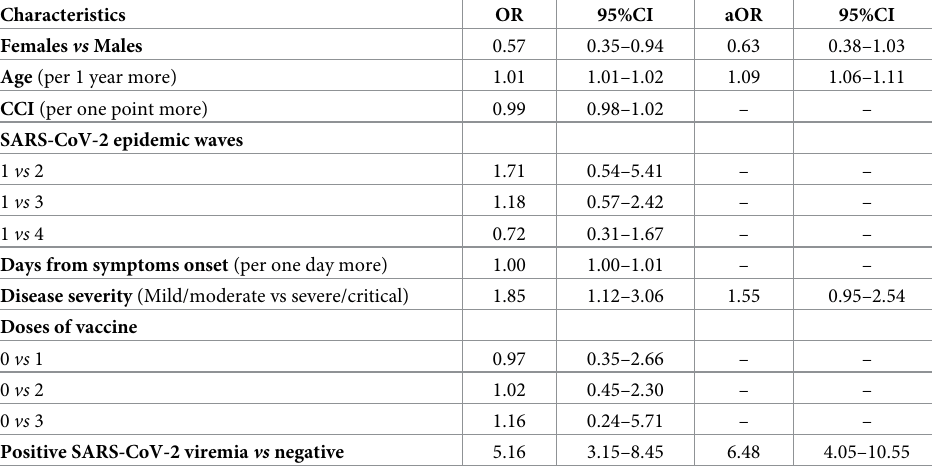
Table 2. Logistic regression analysis of factors associated with death. Characteristics